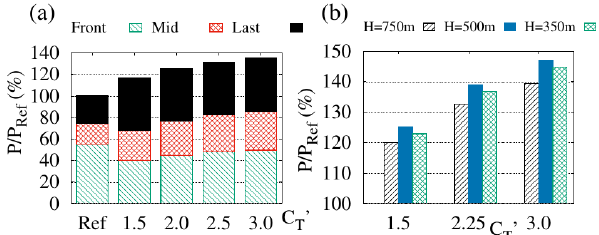
on the average power extracted with Figure B1. Influence of C (cid:48) T ϕ = 30 ◦ tilt control normalized by P Ref : (a) power produced by D = 126m turbines in the H = 750m ABL decomposed into front, = 1 . 5 middle and last row contributions (the baseline, no-tilt C (cid:48) T case is also displayed for comparison and denoted as “Ref”); (b) power produced by D = 180m turbines in the three considered ABLs ( H = 750, H = 500, H = 350m).